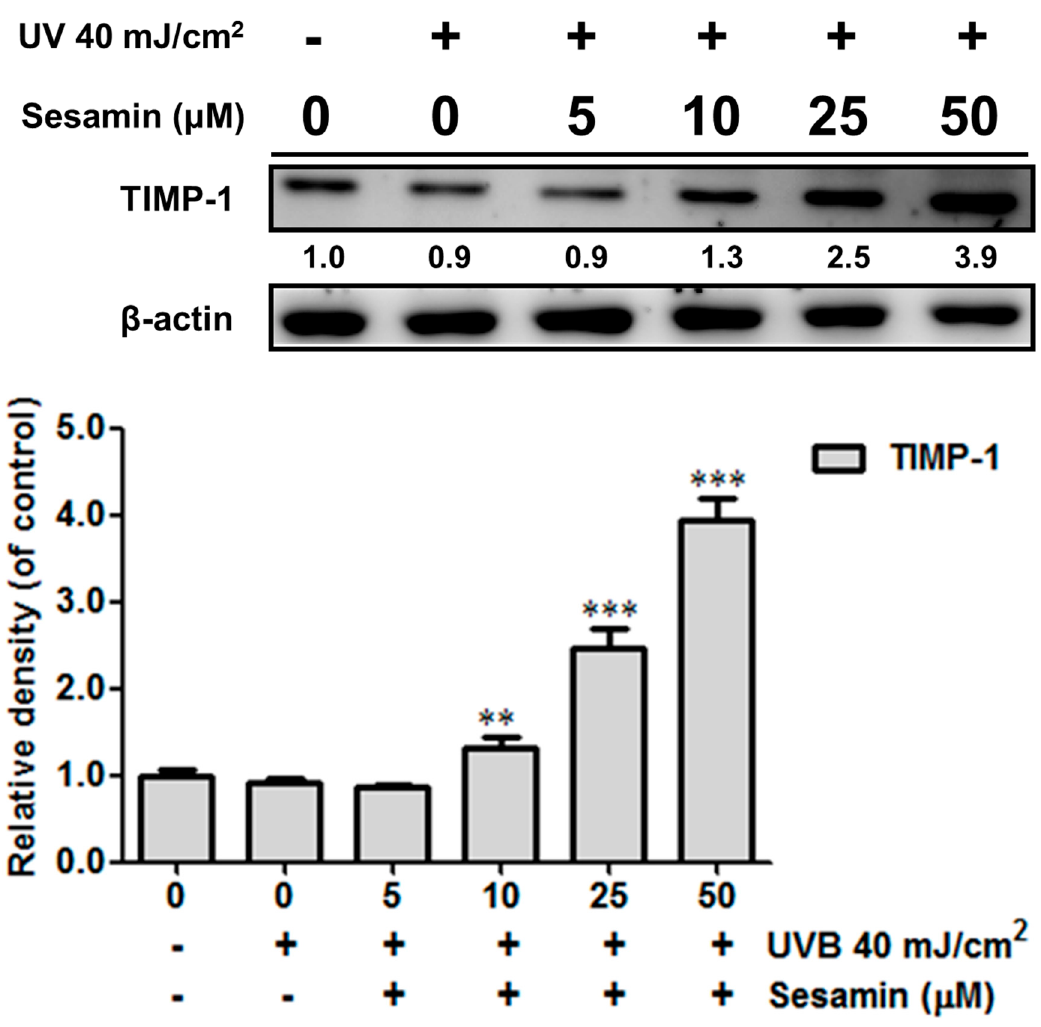
Figure 4. Sesamin reversed the UVB-inhibited tissue inhibitor of metalloproteina-1 (TIMP-1) expression in human skin fibroblasts. ** p < 0.01; *** p < 0.001: Significant difference versus non- treatment